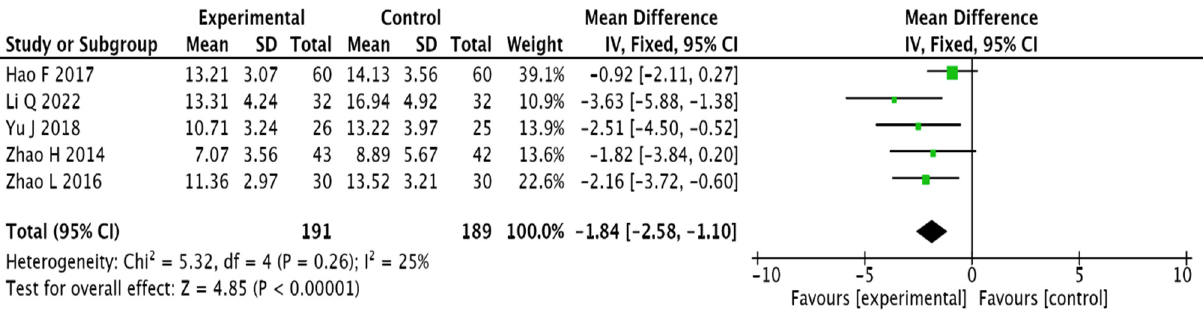
Figure 8. Meta-analysis forest plot of blood glucose. 3.3.6. Blood Lipid Indicators Two studies [15,18] mentioned TC, TG, LDL-C, and HDL-C results and other indica- tors, and presented homogeneity across the studies via a heterogeneity test; therefore, a fixed-e ff ect model was used to perform the analysis: TC (MD = − 0.51, 95% CI ( − 0.82, − 0.21), p = 0.001), TG (MD = − 0.46, 95% CI ( − 0.80, − 0.11), p = 0.009), LDL-C (MD = − 0.28, 95% CI ( − 0.55, − 0.02), p = 0.04), and HDL-C (MD = 0.17, 95% CI (0.07, 0.28), p = 0.001). The results